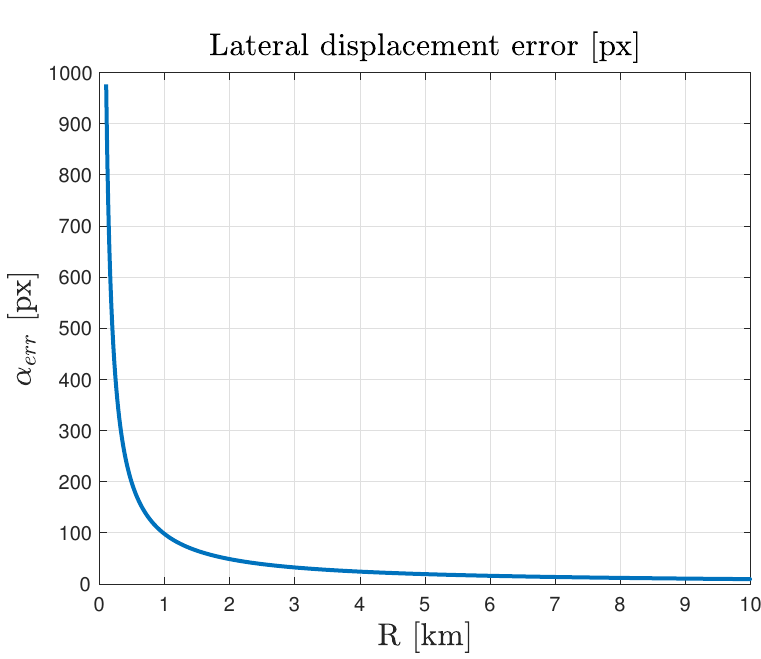
Figure 17. Lateral displacement